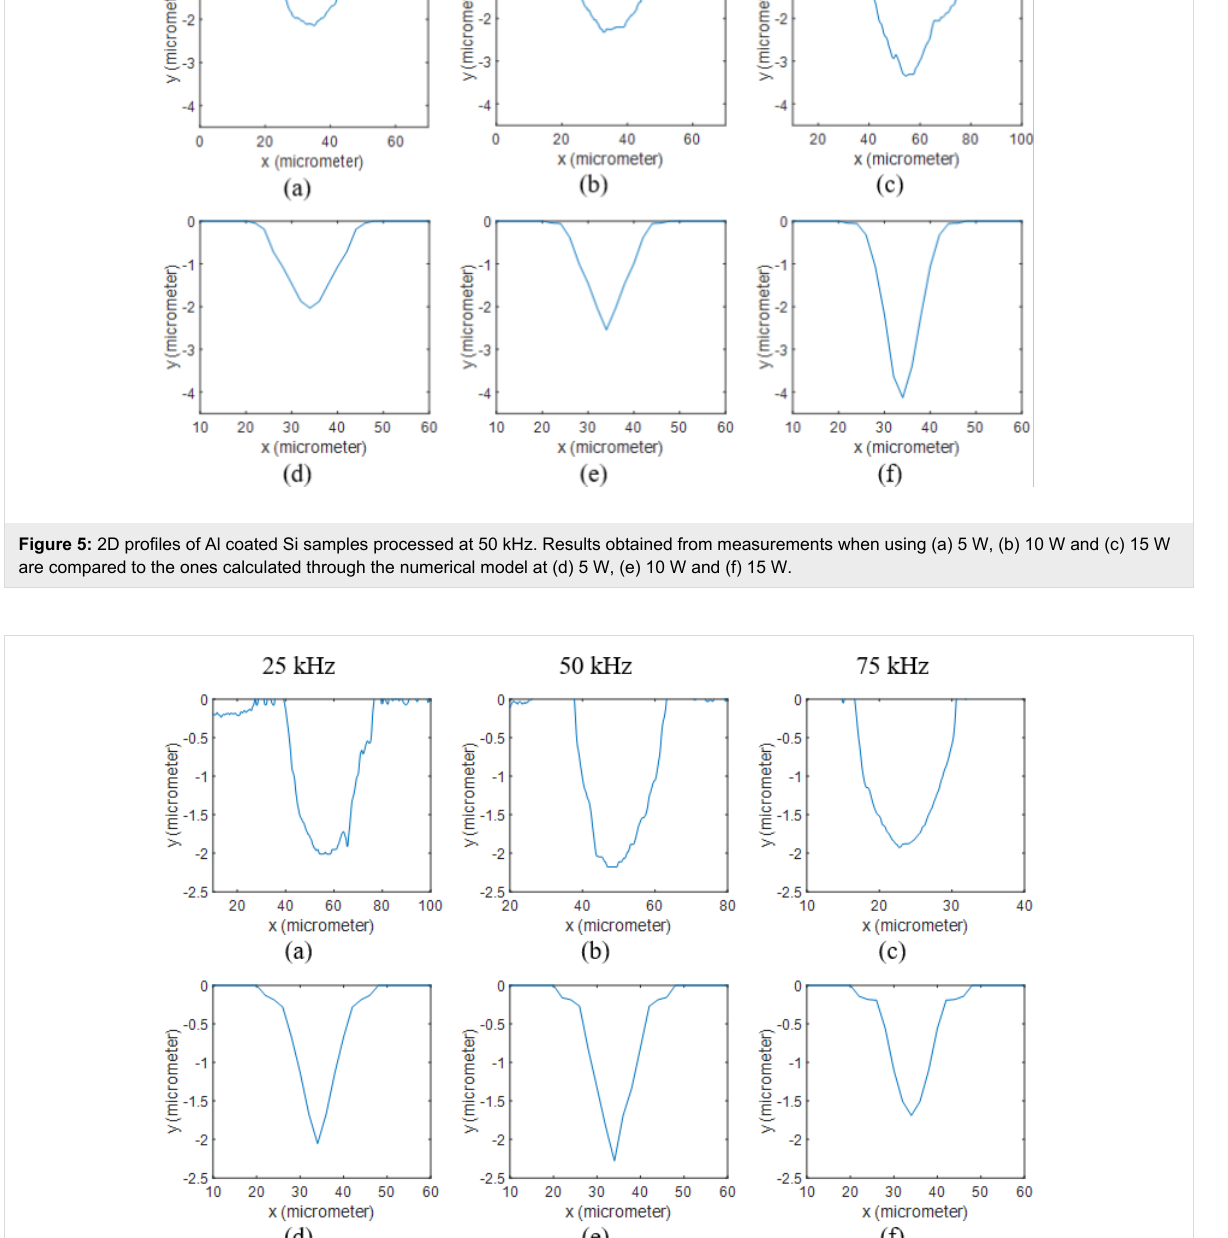
The results presented in this paper can be manipulated for cell patterning applications. Figure 3 depicts that, the size and shape of the heat affected zone and ablated area can be significantly altered by applying a thin film on the surface. As mentioned